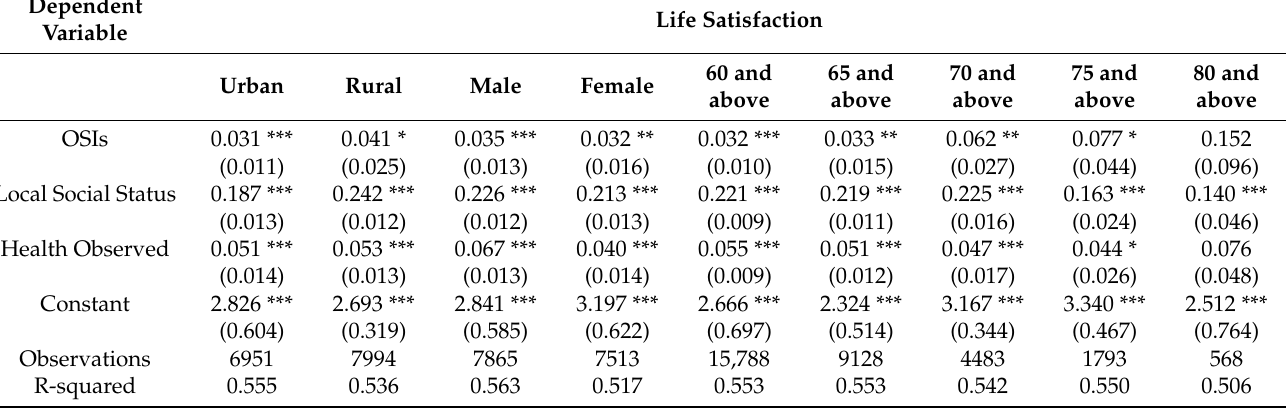
Figure A2. The rural–urban digital divide in China. Source: China Internet Network Information Center (CINIC). Table A1. Heterogeneous effects and sensitivity Tests.